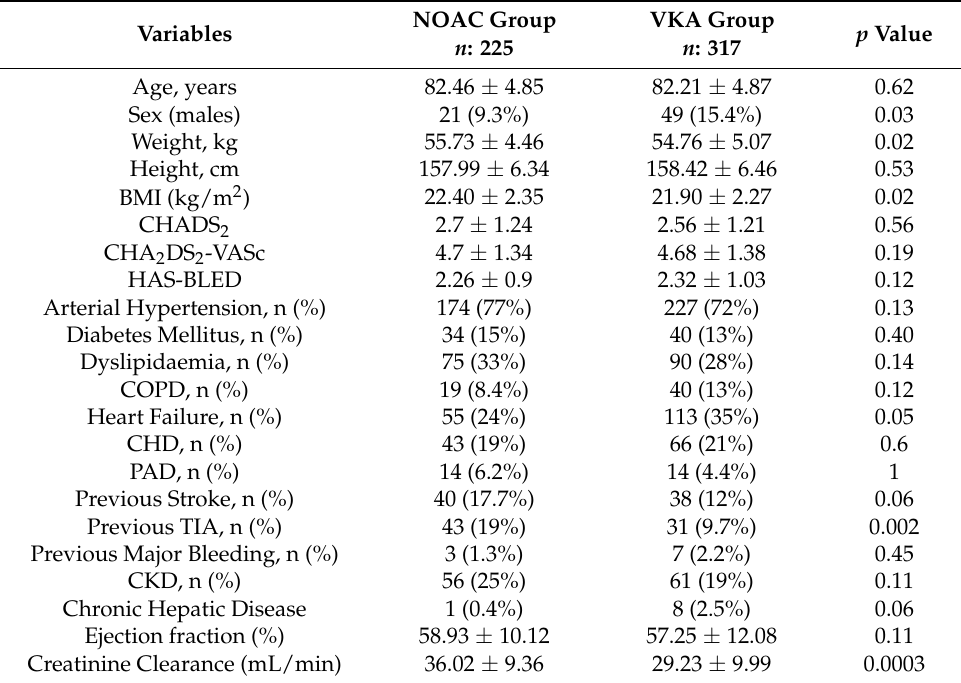
Table 1. Clinical characteristics of the study